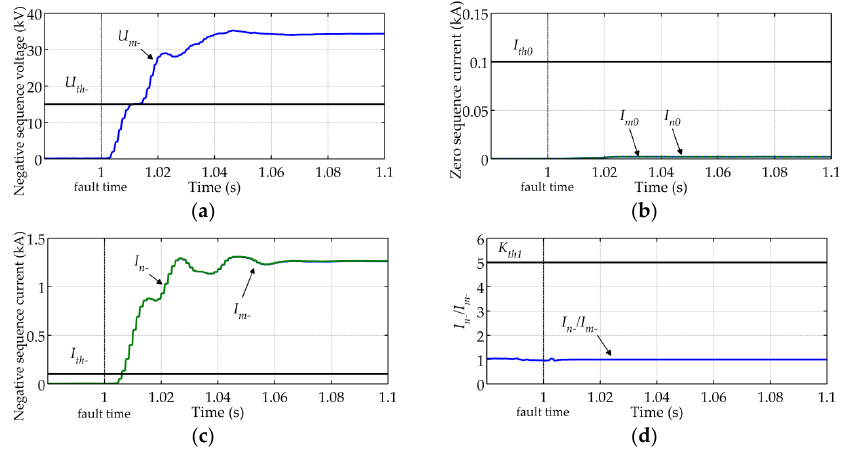
Figure 21. Values detected by relays under an external phase-A-to-ground fault: ( a ) Magnitude of negative-sequence voltage at bus m side of line mn; ( b ) Magnitudes of zero-sequence currents at both sides of line mn; ( c ) Magnitudes of negative-sequence currents at both sides of line mn; ( d ) The ratio between negative-sequence currents flowing through both sides of line mn.